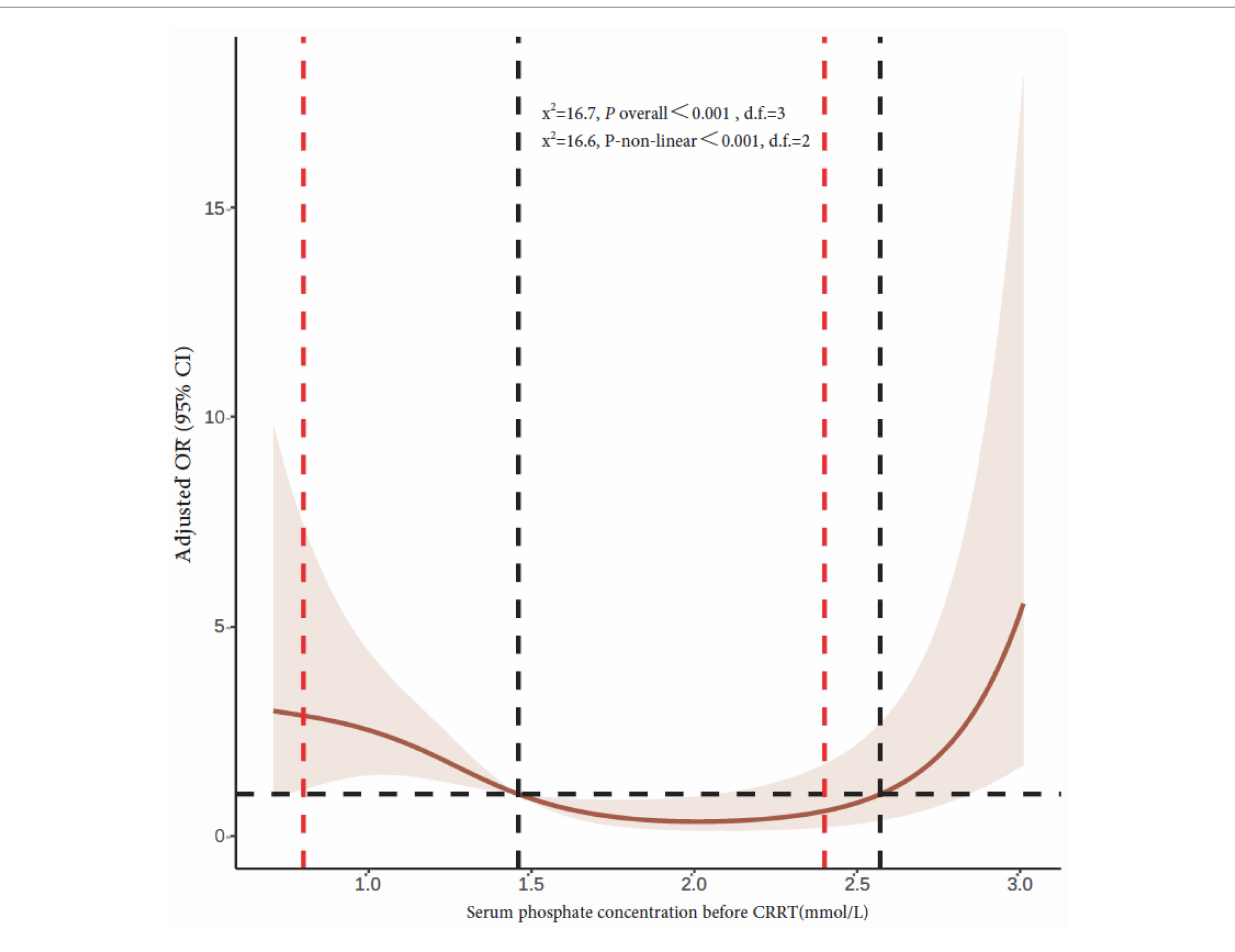
FIGURE 2 Restricted cubic splines of the correlation between serum phosphate concentration and 90-day mortality rate prior to CRRT initiation. The dotted red line on the left indicates hypophosphatemia cutoff, while the dotted red line on the right indicates hyperphosphatemia cutoff. The horizontal black dashed line represents OR=1, and the vertical black dashed line is the serum phosphate concentration at the point where the curve intersects with OR value 1 that are 1.46 and 2.57 mmol/L, respectively. CRRT, continuous renal replacement therapy; OR, odds ratio; CI, con fi dence